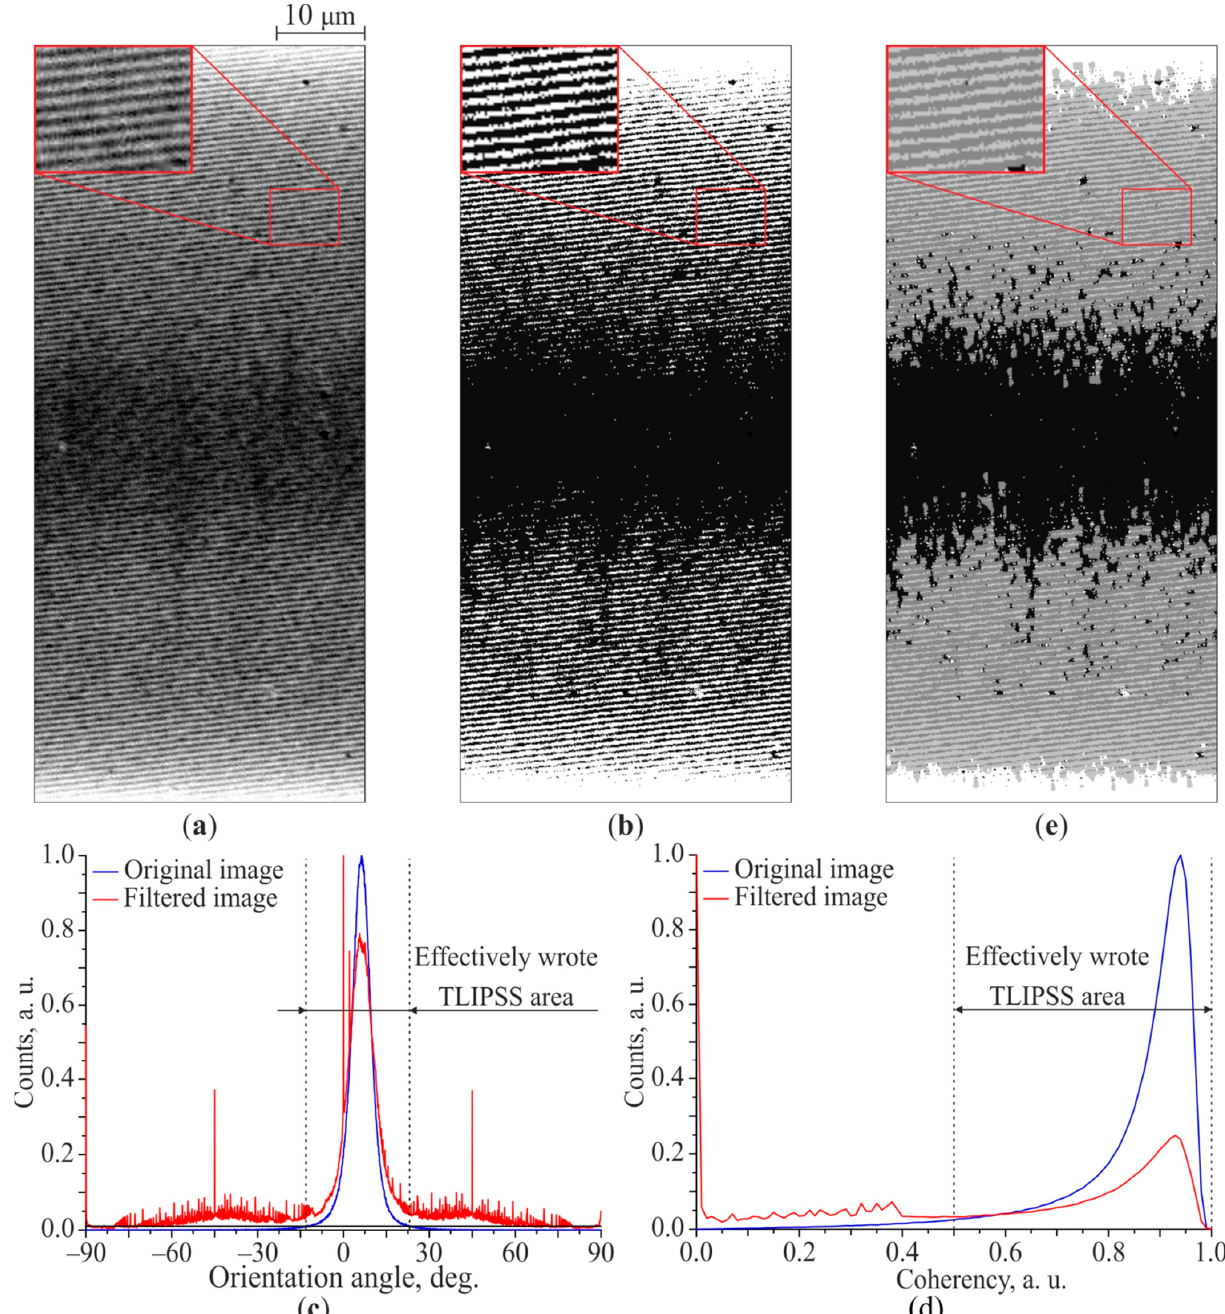
Figure A2. Results of analyzing the SEM images of TLIPSS: the fragment of the original image (writing parameters: P = 250 mW, V = 500 μ m/s) ( a ); the contrast image after filtering by intensity ( b ); graphs of angular distribution ( c ) and coherency ( d ) of pixels; the image after determining the areas of defects of TLIPSS and areas not modified by laser beam ( e ).